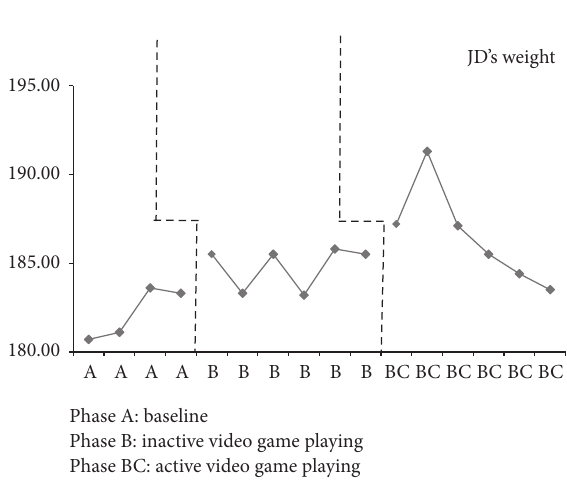
Figure 2: JD’s weight across all